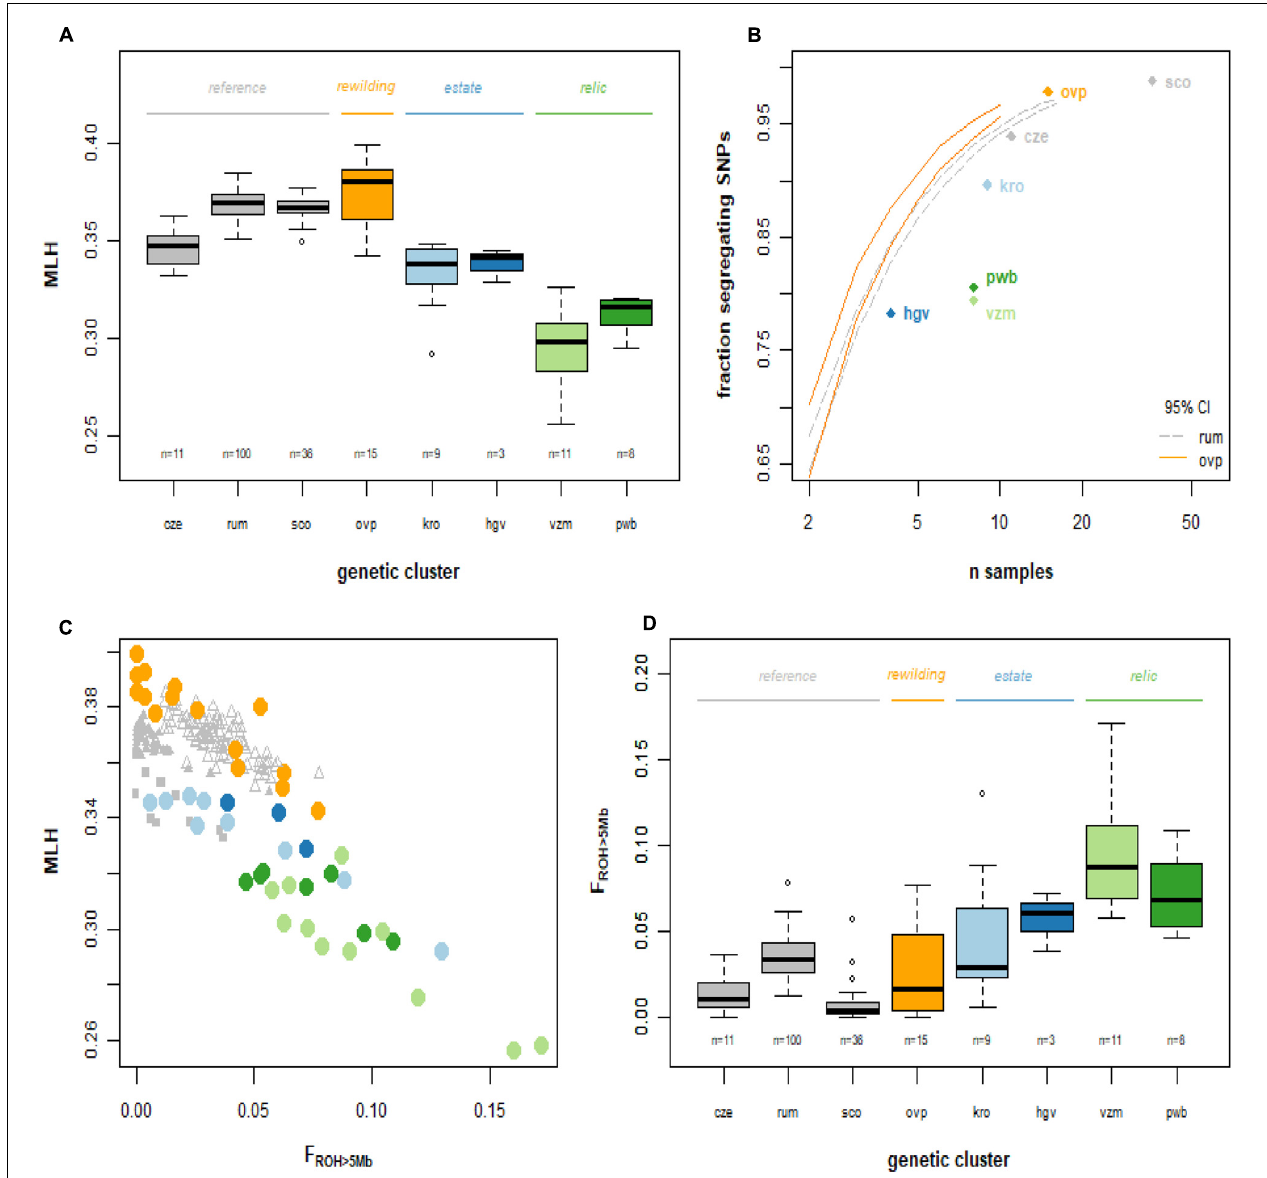
FIGURE 4 | Genetic diversity of the red deer study populations. Abbreviations as in Figures 1 , 2 . (A) Boxplot of observed multilocus heterozygosity. (B) Fraction of monomorphic SNPs, at population level, in relation to sample size. The relic populations of the Veluwe have relatively many monomorphic SNPs. Lines represent the bootstrapped 95% confidence intervals for Rum (dashed gray line) and the allochthonous Oostvaardersplassen (unbroken, orange line) deer populations (i.e., rarefaction curves). (C) Individual F ROH vs. multilocus observed heterozygosity. F ROH is the genomic fraction of all ROHs longer than 5 Mb. (D) Fraction of the genome containing ROH segments > 5 Mb, per individual, grouped over genetic clusters. ROH segments with a length of 5 Mb stem from a common ancestor of maximum 10 generations ago.